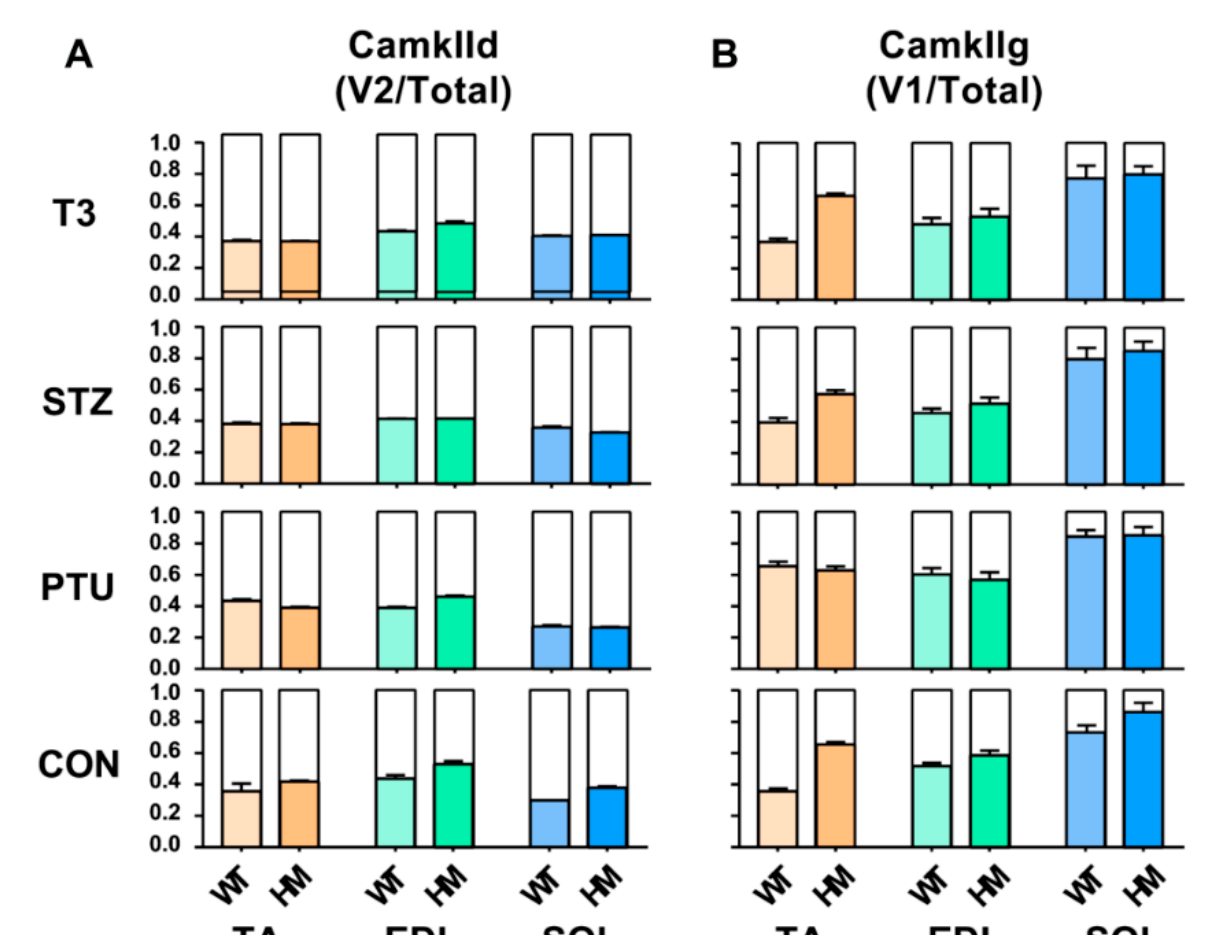
Figure 4. Hormonal effects on CamkIId and CamkIIg major splice variants between WT and HM across different muscles ( A , B ). WT, wildtype; HM, RBM20 homozygous knockout; CON, control; PTU, propylthiouracil; STZ, streptozocin; T3, trriodothyronine; TA, tibialis anterior; EDL, extensor digitorum longus; SOL, soleus.